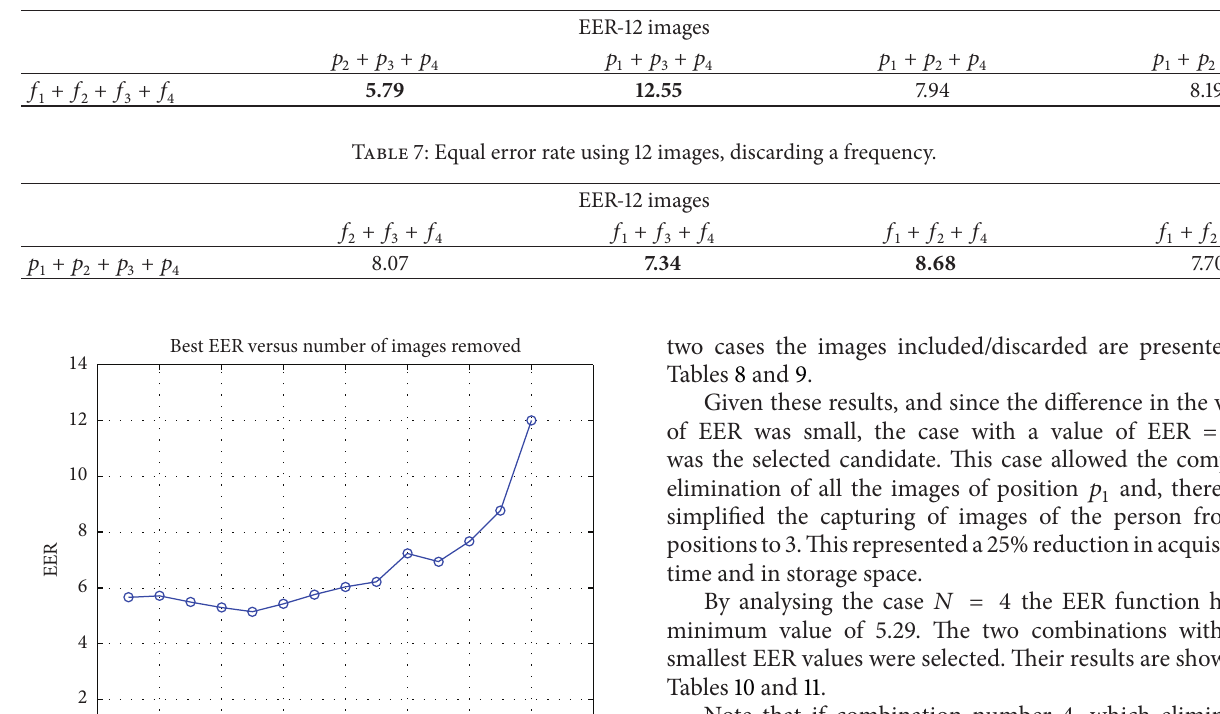
Table 6: Equal error rate using 12 images, discarding a position.